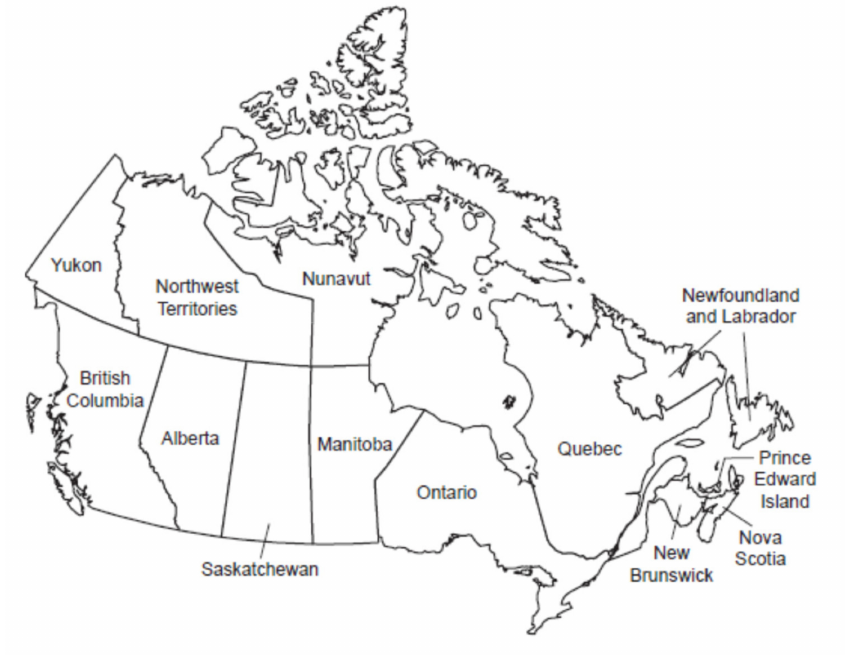
Figure 1. Map of Canada with provinces and